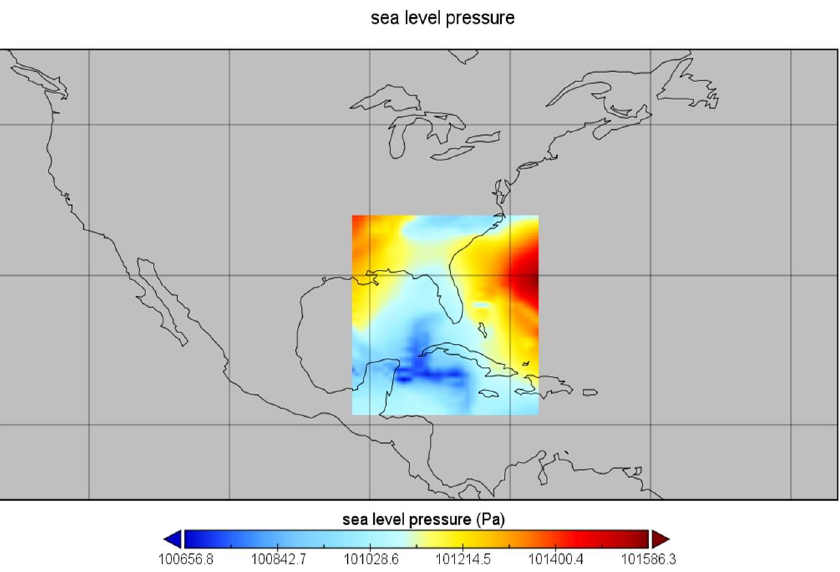
Figure 1. An example of collocation MERRA2 dataset with one tropical cyclone instance